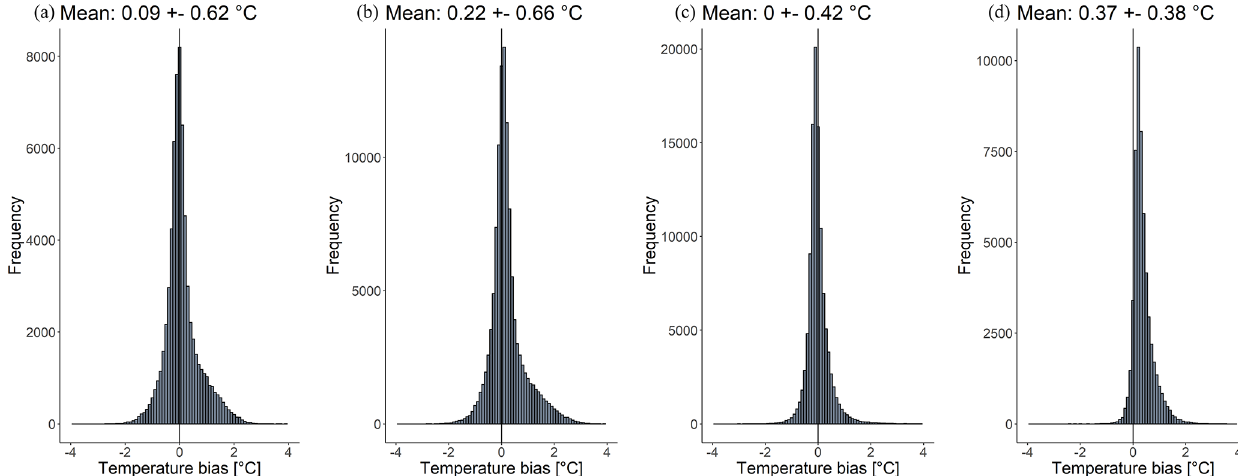
Figure 9. Histograms of temperature difference ( (cid:49)T = T LC-R − T AWS ) for each reference station, (a) LC-R01, (b) LC-R02, (c) LC-R04 (d) and LC-R05, at QC level 0 and QC level 1. The mean differences and their standard deviations are given above the graphs. Note that the ranges on the y axis differ for the different subplots. The temperature difference was calculated for all measurements between the installation date of each LC-R and December 2021.